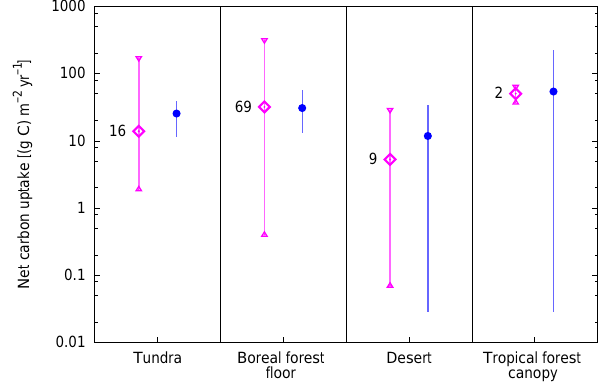
Figure 2. Comparison of LiBry estimates to field measurements. NPP estimated by LiBry compared to field measurements from four biomes, defined after Olson et al. (2001). The blue dots show the average simulated NPP for each biome, and the blue vertical bars show the range of NPP values between the different grid cells in a biome. The magenta diamonds correspond to the median of NPP values measured in the field on the small scale; the magenta vertical bars denote the range of the field measurements. Left of the ma- genta diamonds the number of field measurements is shown that is considered for the respective biome. Details can be found in Porada et al. (2013).